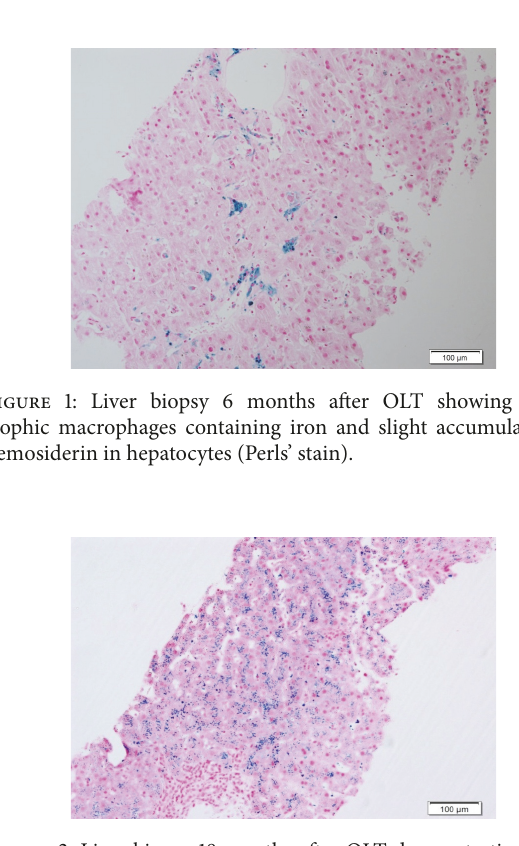
Figure 2: Liver biopsy 18 months after OLT demonstrating heavy granular iron deposition in hepatocytes and macrophages corre- sponding to hemosiderosis (Perls’